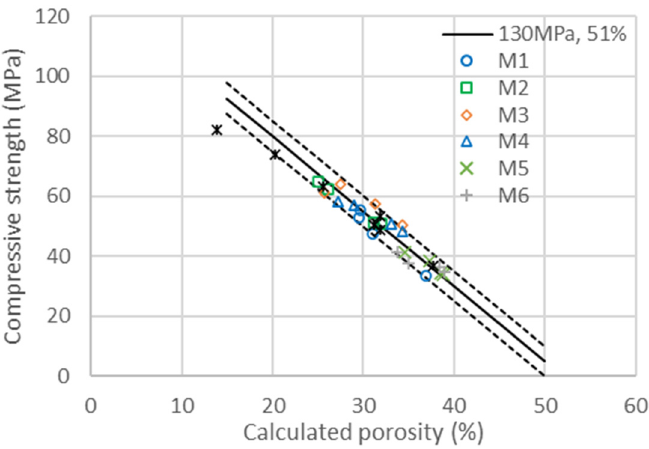
Figure 9. Compressive strengths as a function of the calculated porosity for the diverse substitutions of the six metakaolins (M1–M6) and cement (C) presented in Table 10 at 28 days. The continuous line corresponds to the linear evolution of compressive strength with porosity, as explained in Equation (3) with σ 0 = 130 MPa and φ m = 51%. The dotted lines are a variation with ± 4% of both σ 0 and φ m.